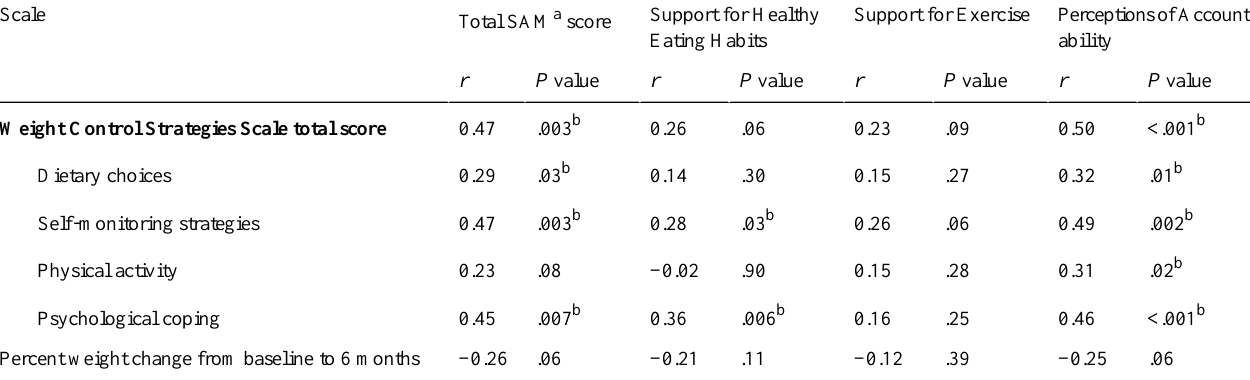
Table 5. Correlation between the supportive accountability measure (total scores and subscales) and adherence to weight control strategies and weight change from baseline to 6-month